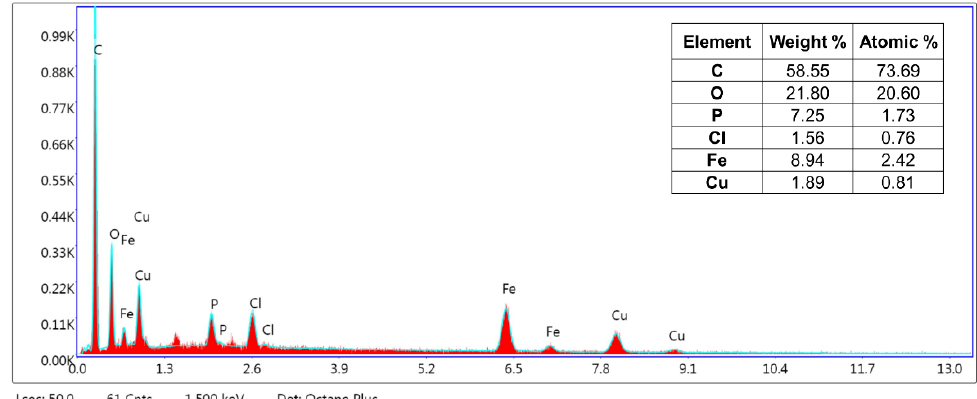
Figure 7. EDX spectrum of the Cu-Fe 3 O 4 -PAC catalyst.